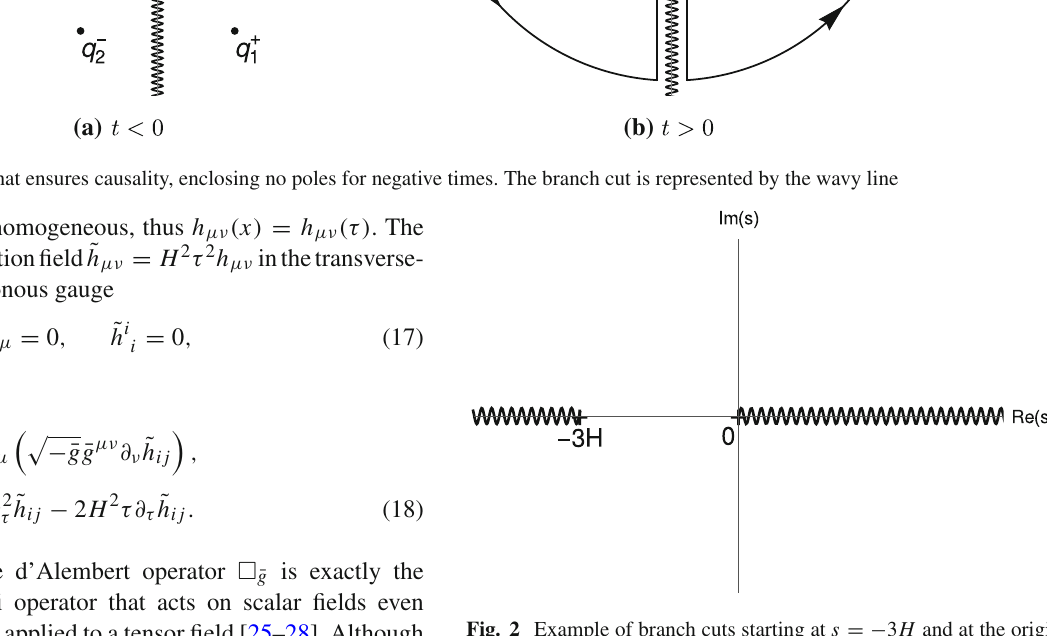
This time, two branch points show up coinciding with the zeros s 0 = 0 and s 1 = − 3 H . The corresponding branch cuts start at s 0 and s 1 and goes up to infinity (Fig. 2), preventing us from including the massless mode s 0 and the Hubble friction s 1 in the theory. Therefore, γ ij must only develop poles at